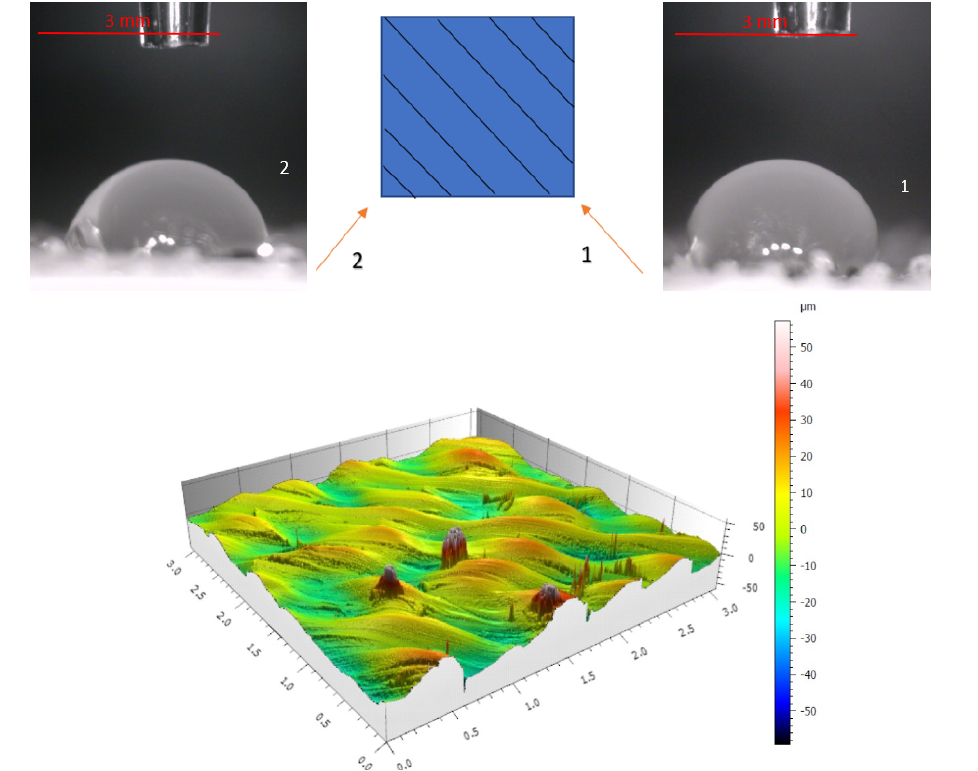
Figure 5. Wettability and morfology measurements